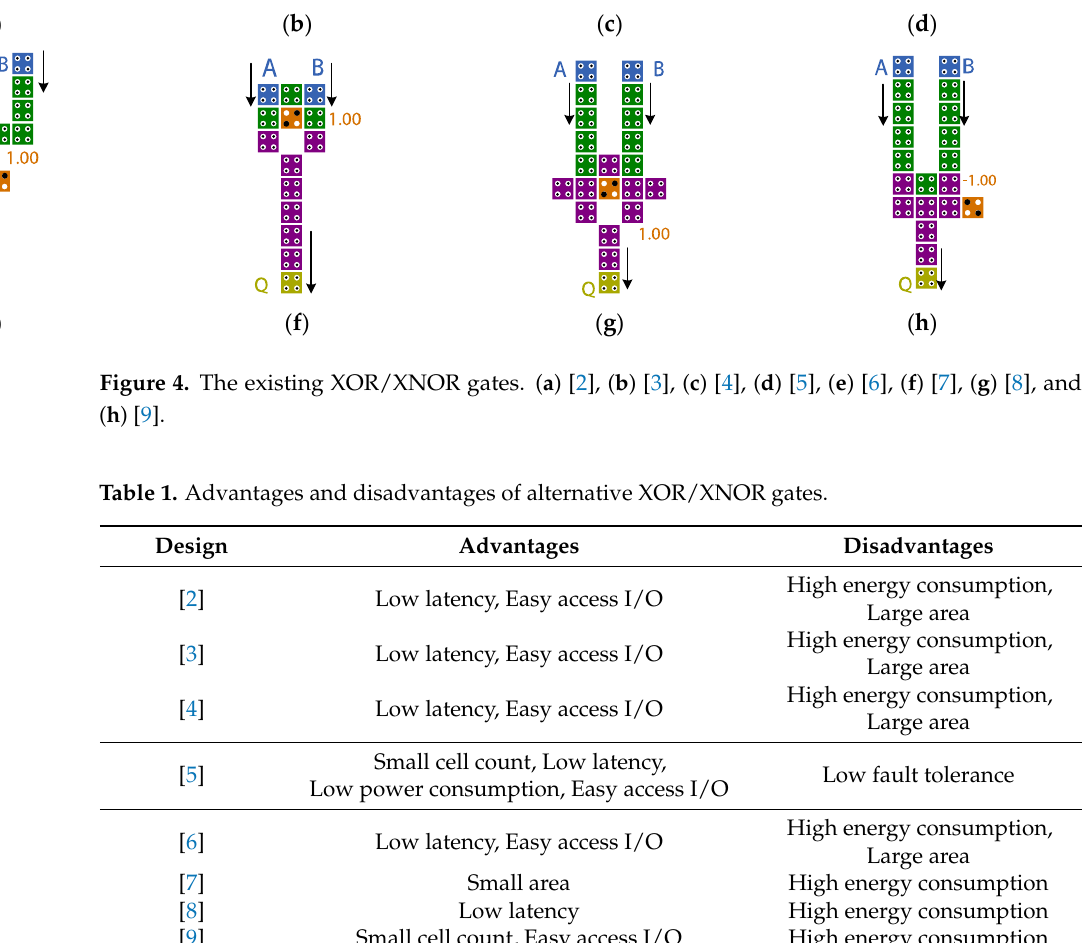
Table 1. Advantages and disadvantages of alternative XOR/XNOR gates.